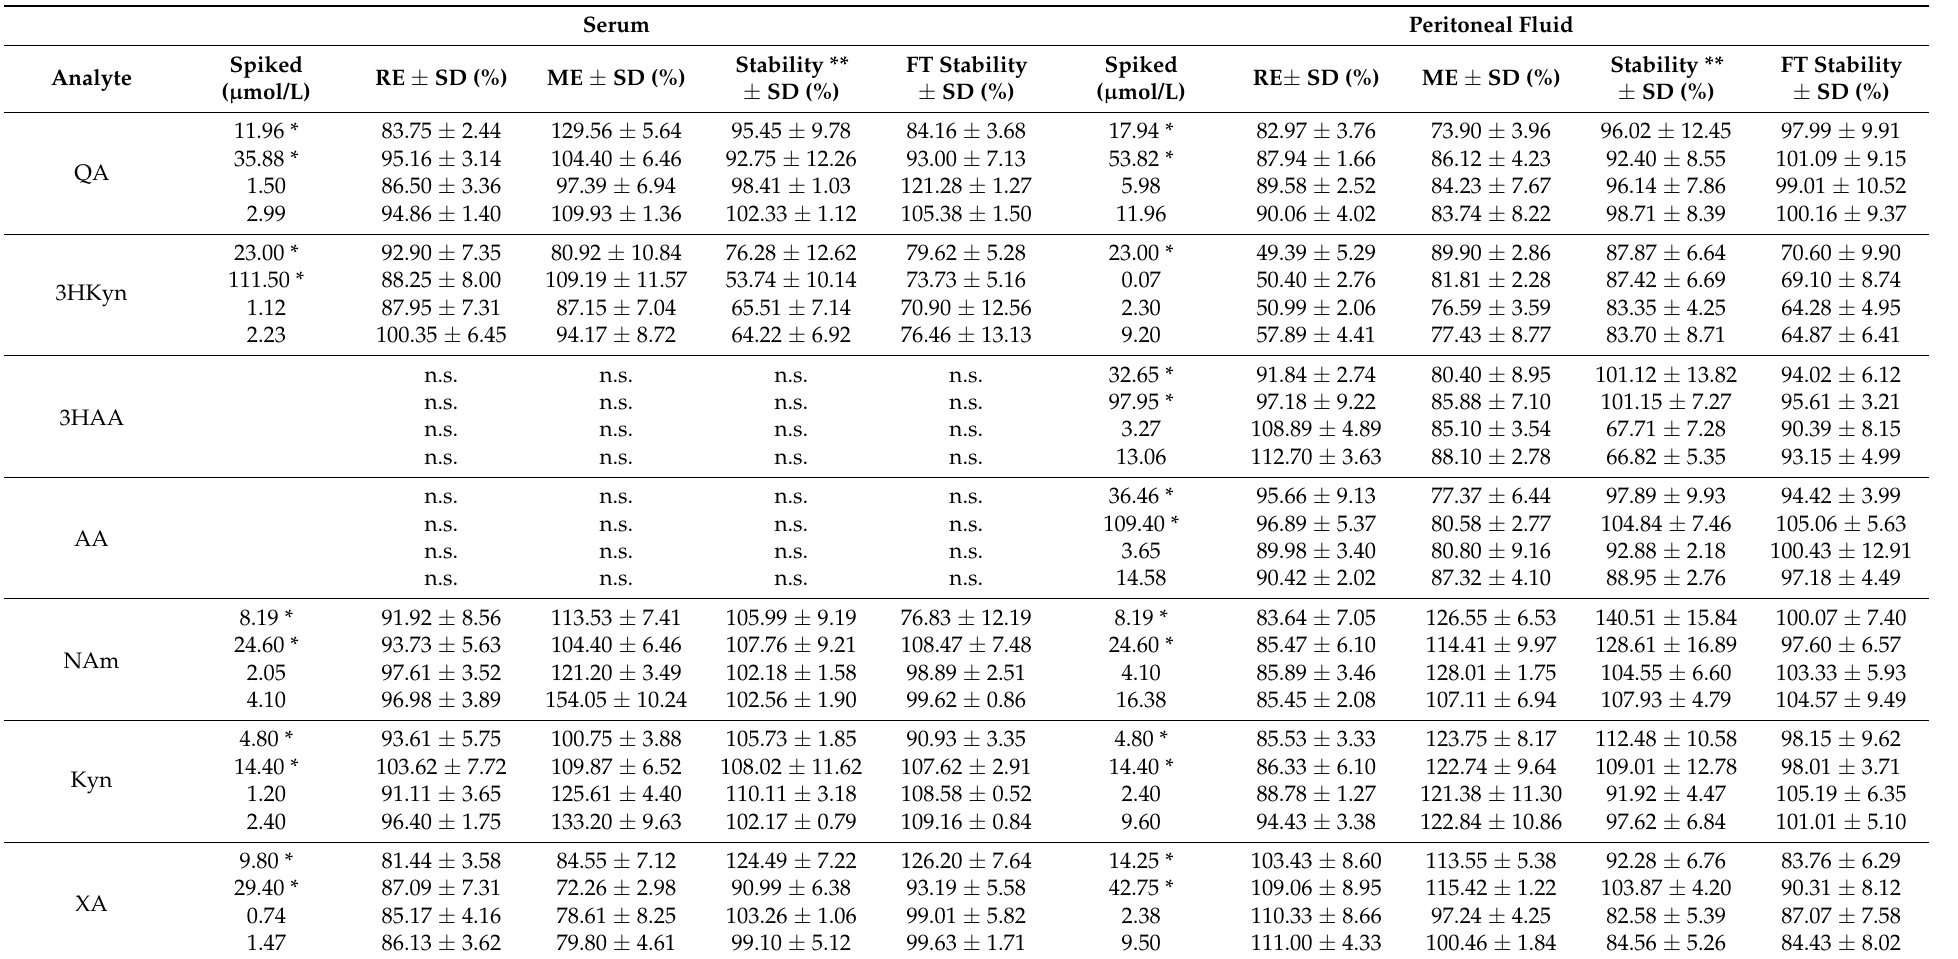
Table 4. Recovery, matrix effects, and